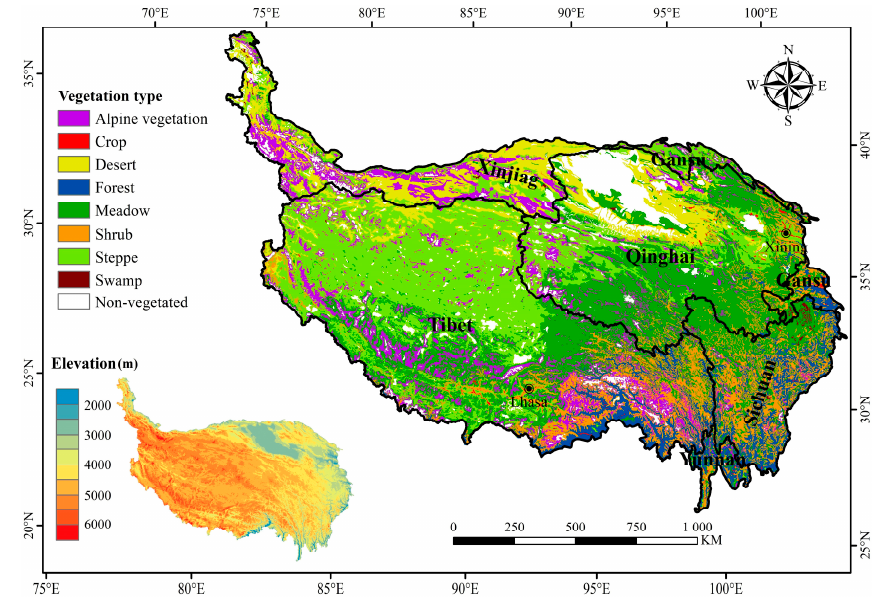
Figure 1. The vegetation type and elevation of the QTP.